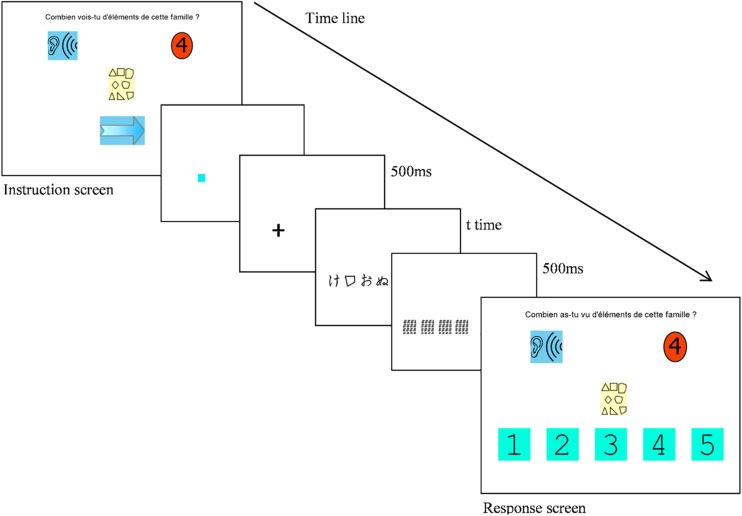
Example of a trial for MAEVA© training. Instruction n° 4 (How many elements of this family did you see?) is presented; T time is the presentation time defined by the algorithm.